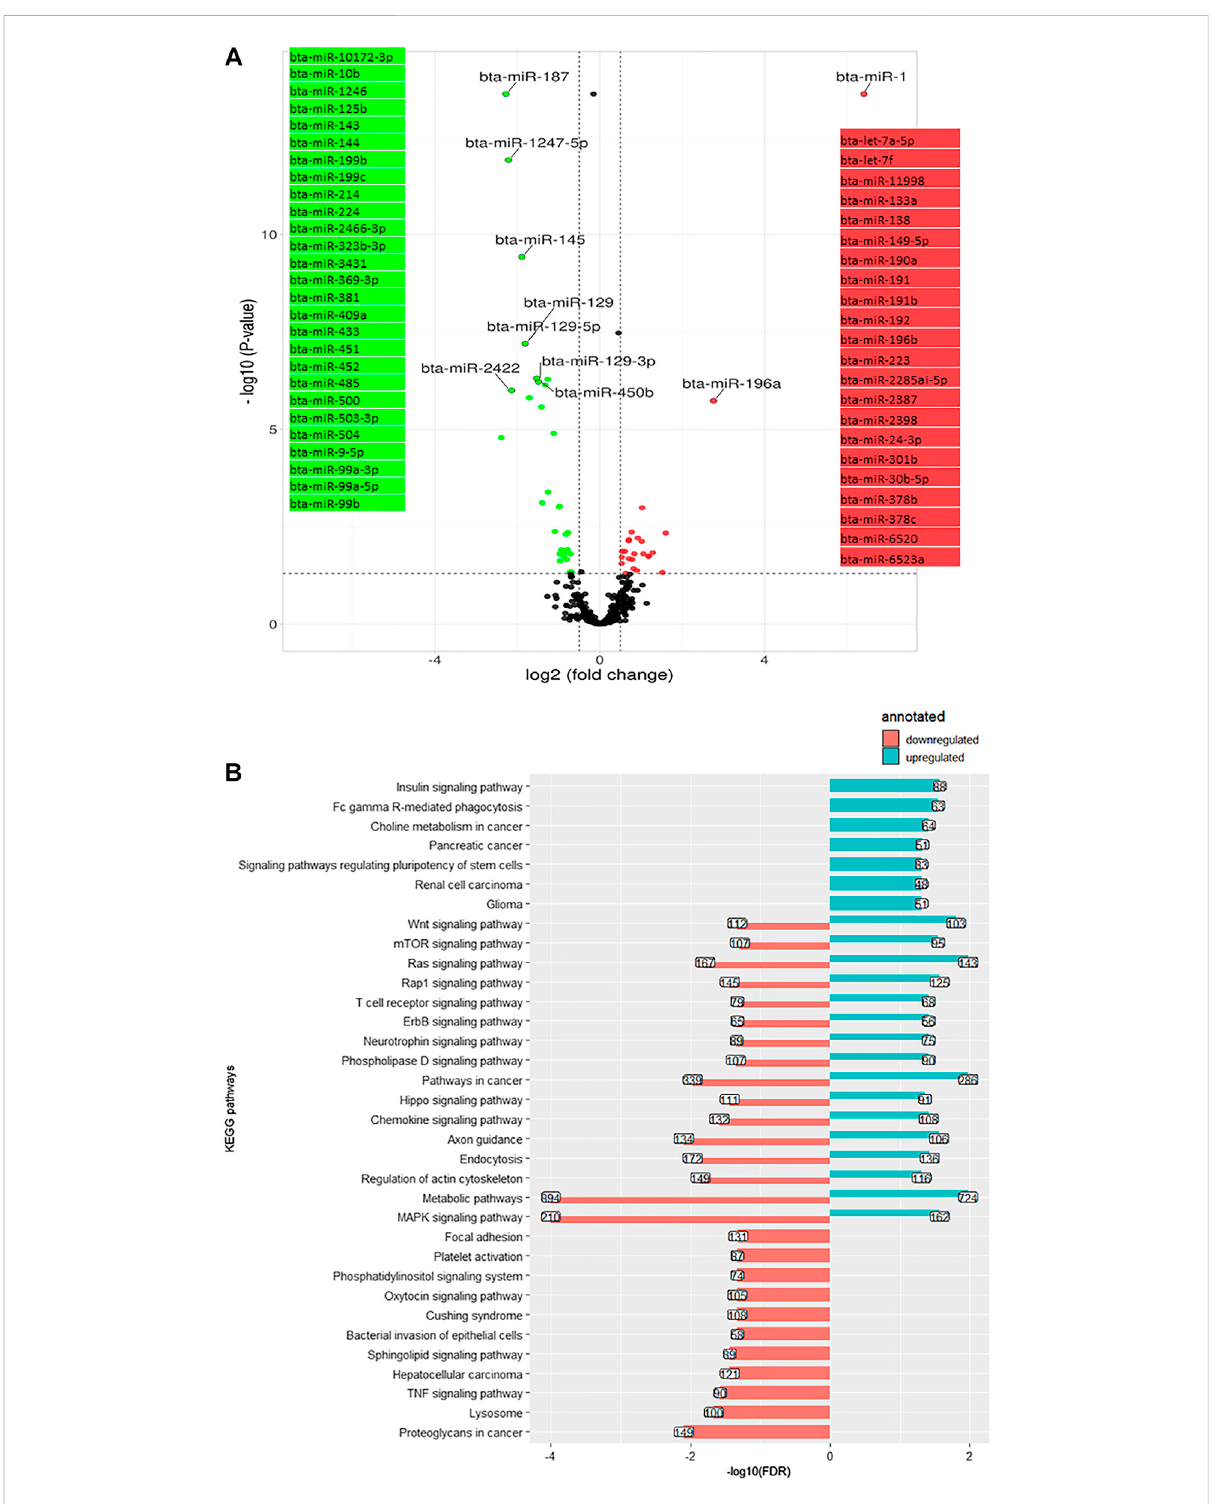
FIGURE 5 (A) . Volcano plot representing differentially expressed miRNA (DEM) between day +1 and +28 relative to parturition; increased (red dots in top right) and decreased (green dots in top left) miRNA in d+28/d+1 are highlighted ( p < 0.05 and log2 fold change (FC) > 1.3). (B) . KEGG pathways annotated to DEM; Bars indicate proportional to the false discovery rate (FDR) adjusted p -value, and the box on each bar represents the genes count